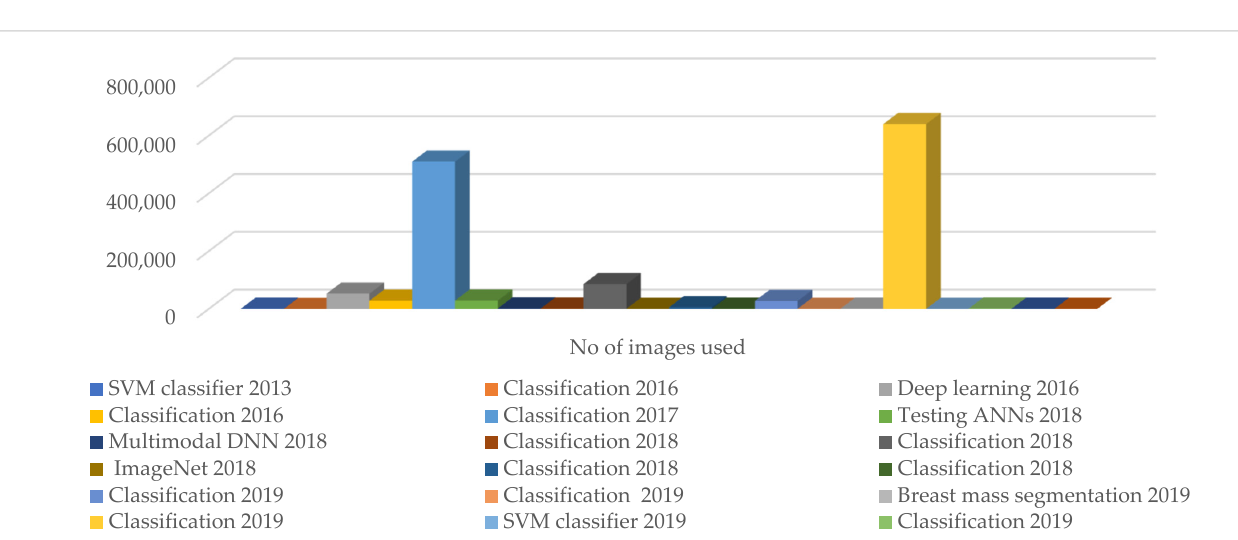
Figure 3. Size of input or training data used by the different countries where the studies were carried out.